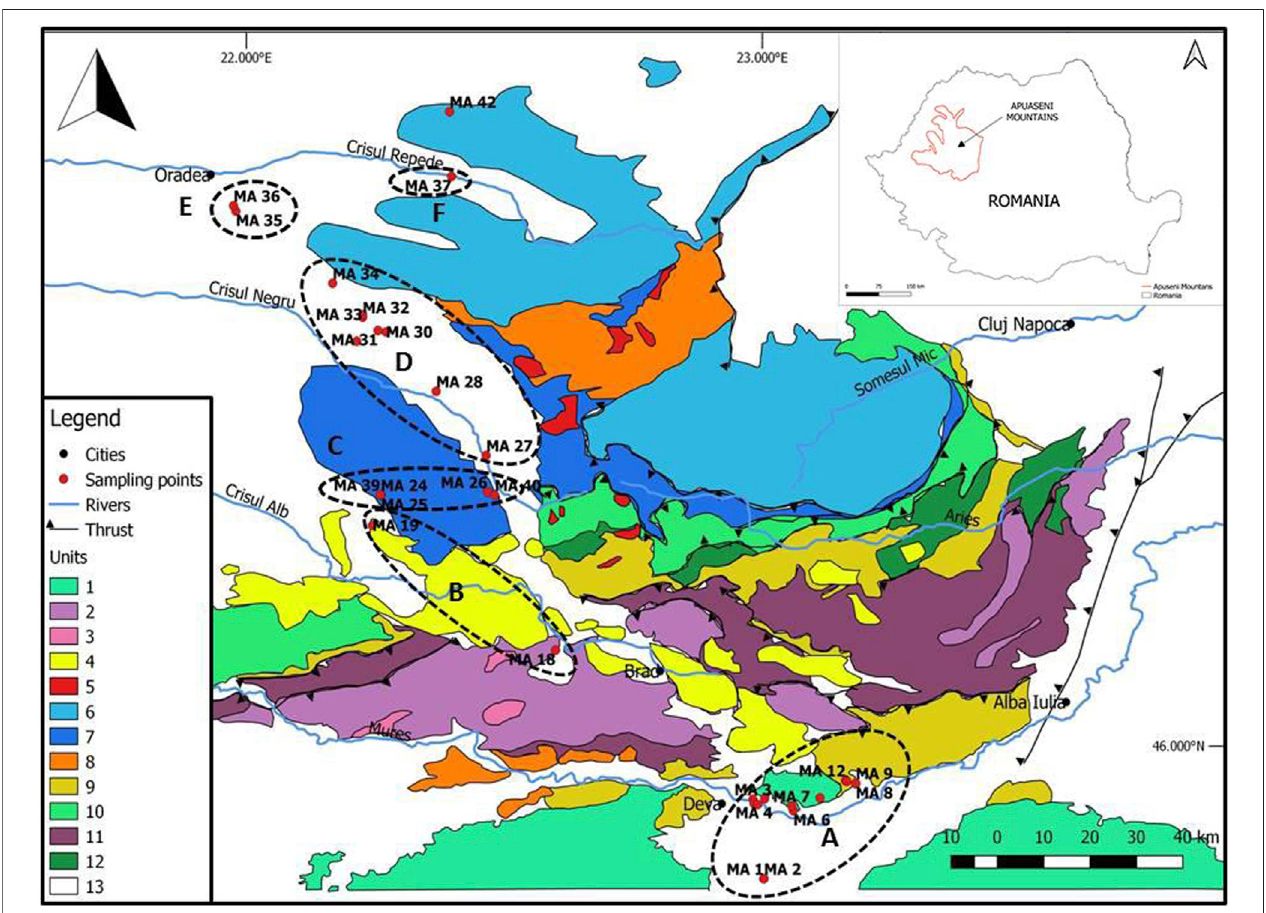
FIGURE1| ThegeneralgeologicalstructureoftheApuseniMts.anddistributionoftheinvestigatedareas(mapmodi fi edafterKounovandSchmid,2013;Gallhofer et al., 2017). 1. Supragetic, getic nappes; 2. Ophiolites (mainly Jurassic); 3. Jurassic granitoids; 4. Neogene magmatic rocks; 5. Late Cretaceous intrusions; 6. Bihor nappe;7.Codrunappesystem;8.LateCretaceousvolcanics;9.Gosau-typesediments;10.Highi ş -Poiana,Biharia,Muncel-Lup ş anappes;11.EarlyCretaceous fl ysch; 12.BaiadeArie ş nappe;13.Paleogenetorecentsedimentaryunits;A — Mure ş area;B — Zarandbasin;C — Moneasa-Va ş c ă u;D — Beiu ş Depression;E — Felixarea; F — Vad-Borod